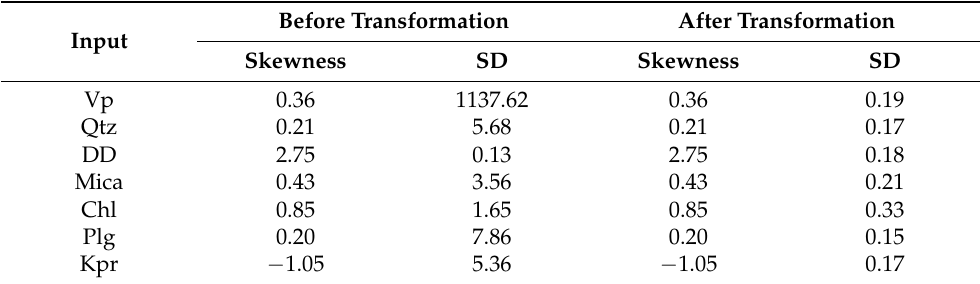
Table 3. Details of inputs distribution before and after the transformation.